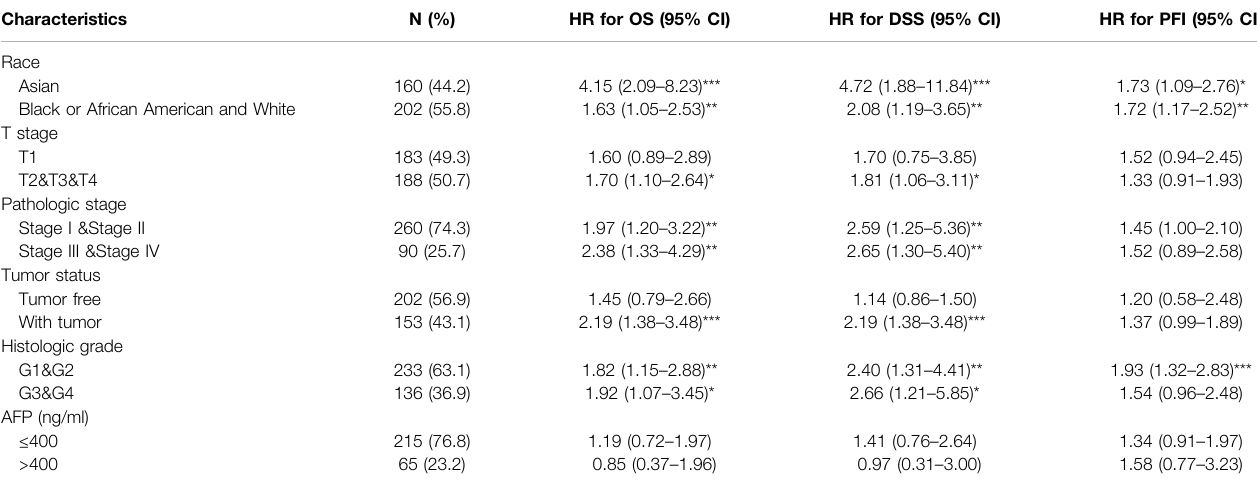
TABLE 5 | Prognostic performance of EXO1 on the clinical outcomes of HCC patient subgroups based on the Cox regression analysis.